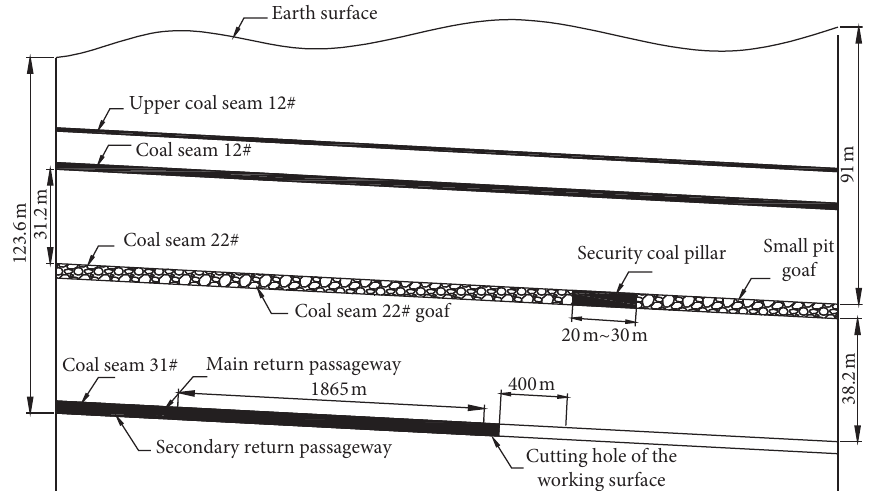
Figure 1: Relationship between coal seam 31# and the overlying coal seam.